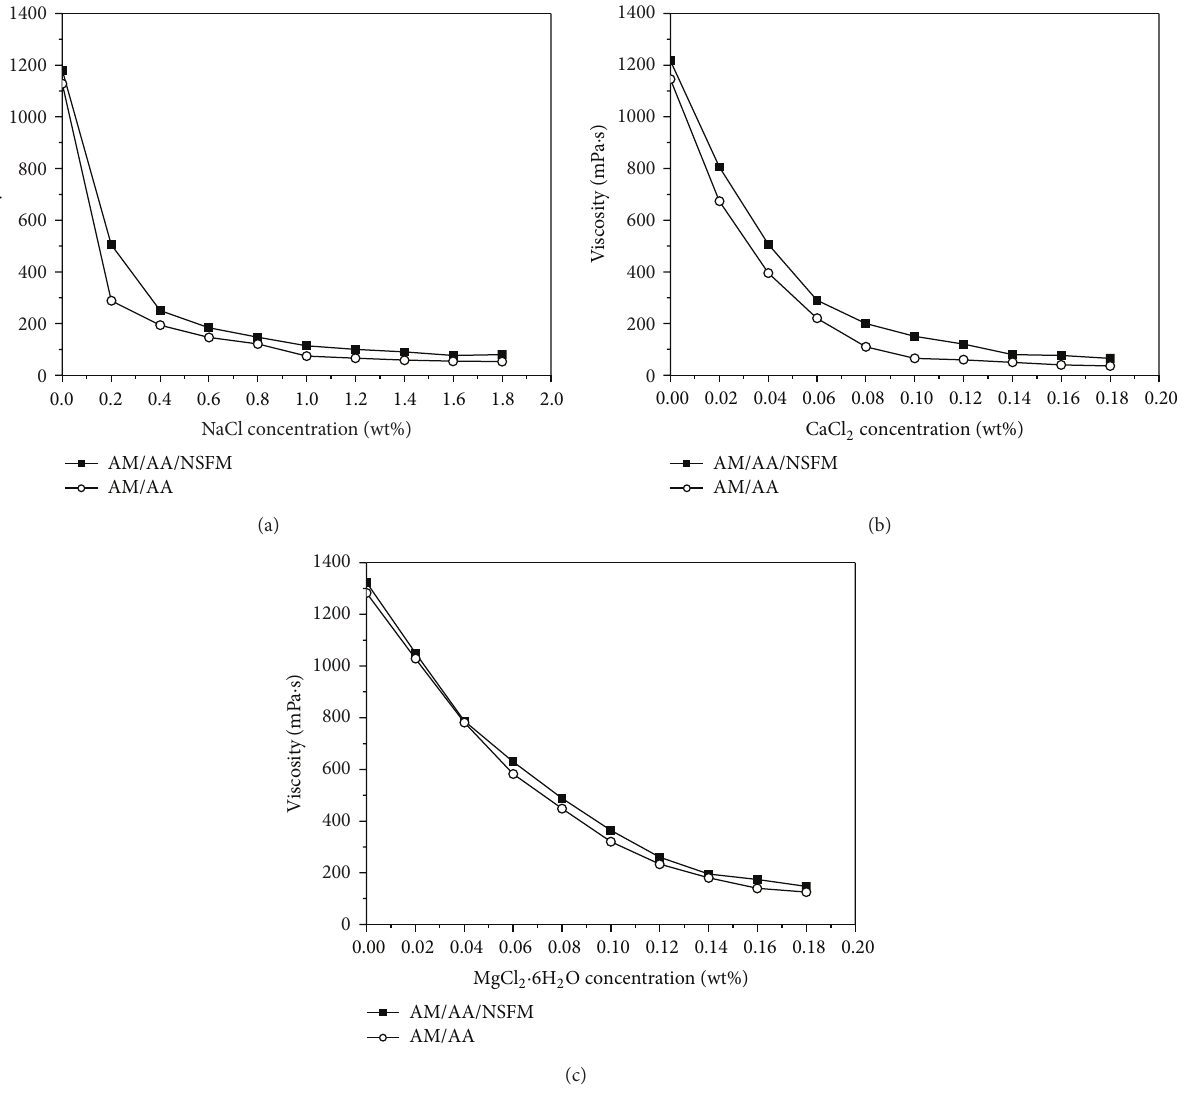
Figure 10: Salt tolerance ((a) NaCl, (b) CaCl 2 , and (c) MgCl 2 ⋅ 6H 2 O) of AM/AA and AM/AA/NSFM solutions (0.5wt%) at 20 ∘ C. The viscosity of copolymer solution was measured by Brookfiled DV-3 viscometer at 7.34s −1 using number 62 rotor (rotation speed: 18.8r/min) or number 61 rotor (rotation speed: 18.5